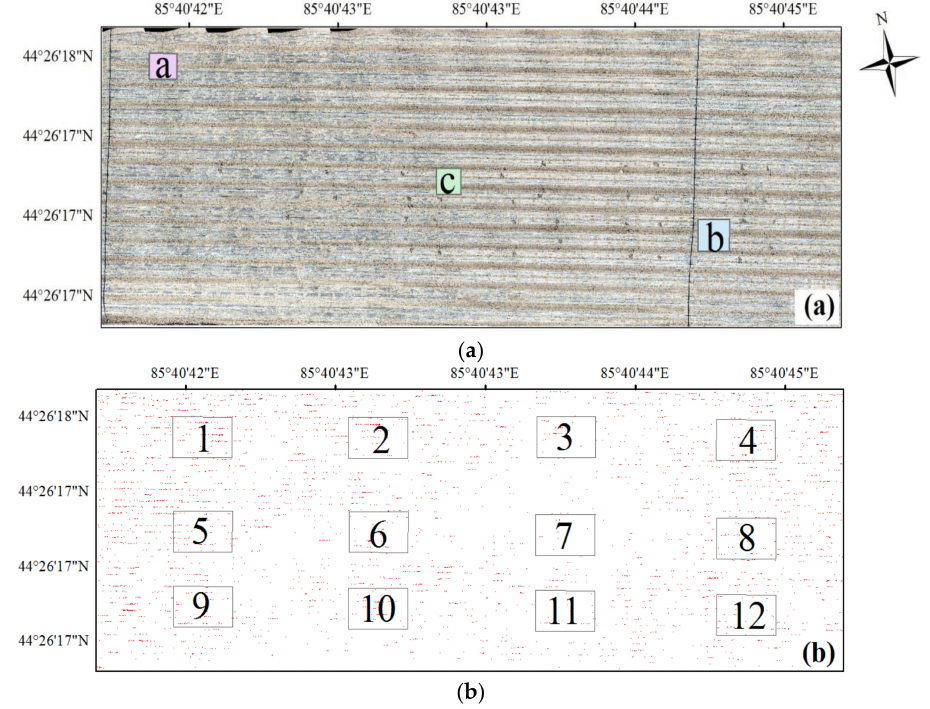
Figure 4. The true-color stitching image ( a ) and the classification result of the study area ( b